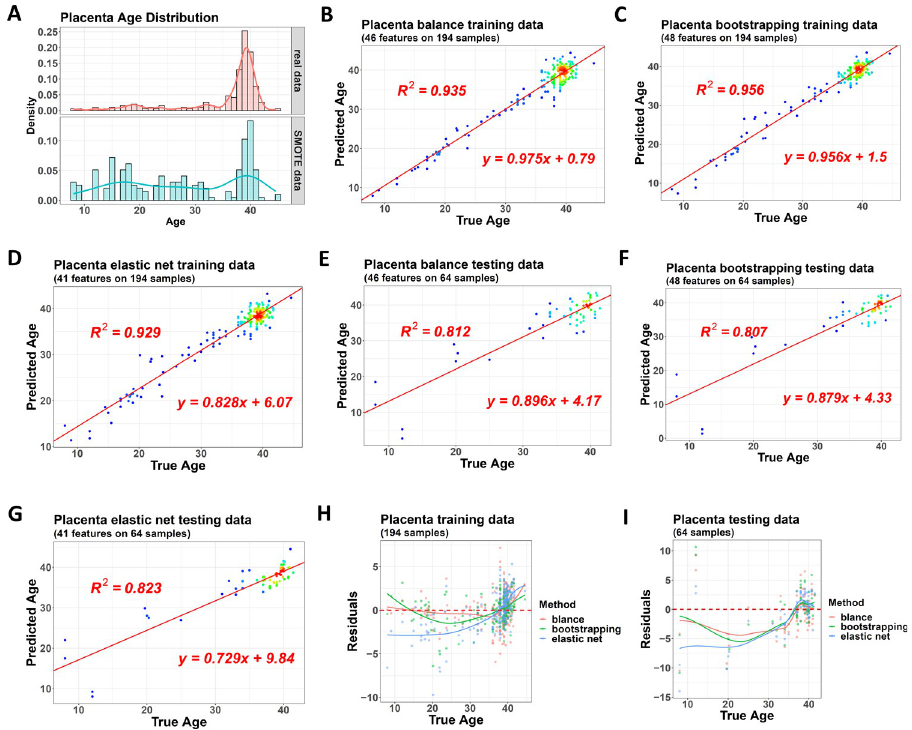
Fig 2. Performance of the three clock models on the gestational age dataset. (A) The original training dataset has a biased gestational age distribution (upper). At the same time, the balanced clock model adjusts it to a balanced one (lower), with samples from all the 10 base learners combined and shown here, including synthesized samples from SMOTE and repeated samples due to bootstrapping and bagging. (B) to (D) Performance of the balanced model (B), bootstrapped model (C), and single normal model (D) on the same training dataset. The color gradients of the dots indicate the density of the samples. (E) to (G) Performance of the three models on the same testing dataset. (H) and (I) Residuals of the three models in training and testing